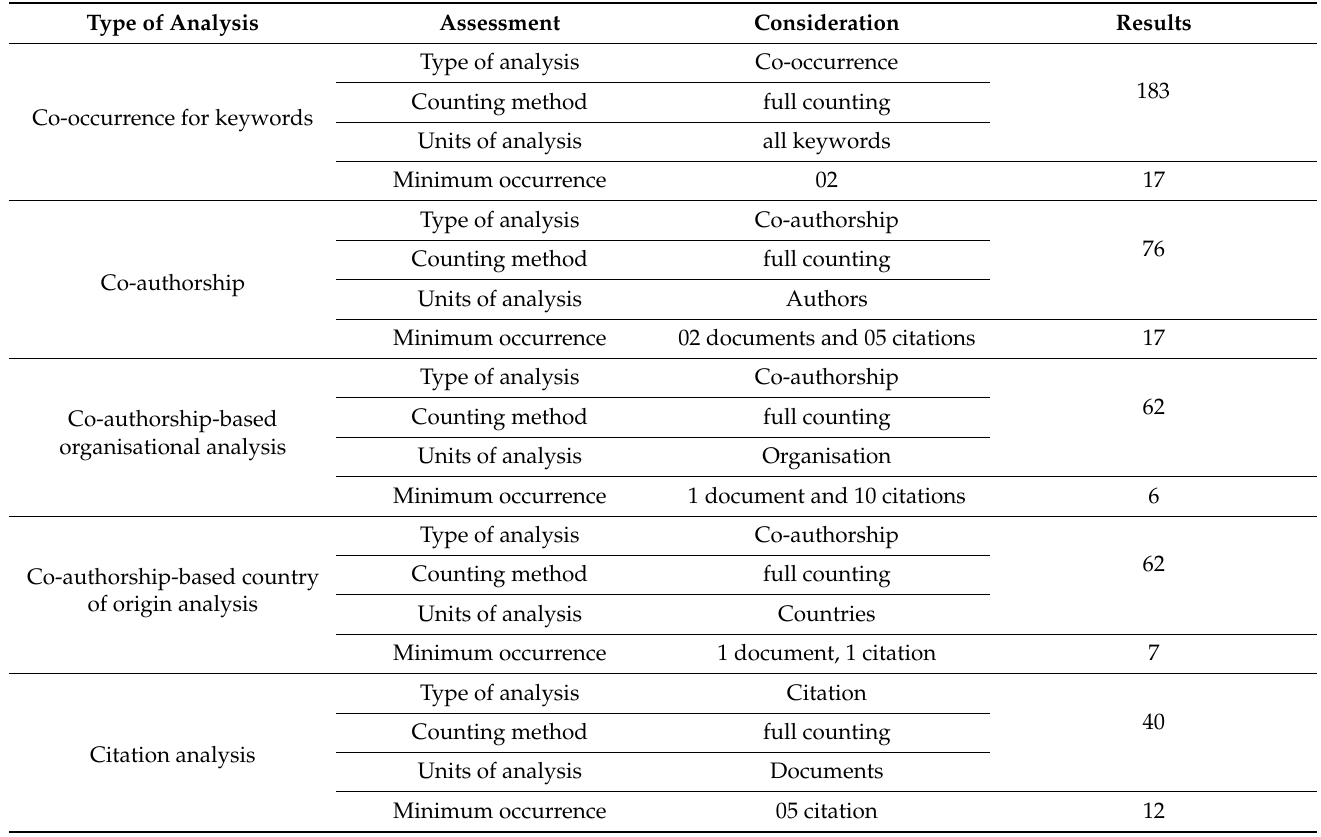
Table 3. Analyses carried out on the retrieved articles.